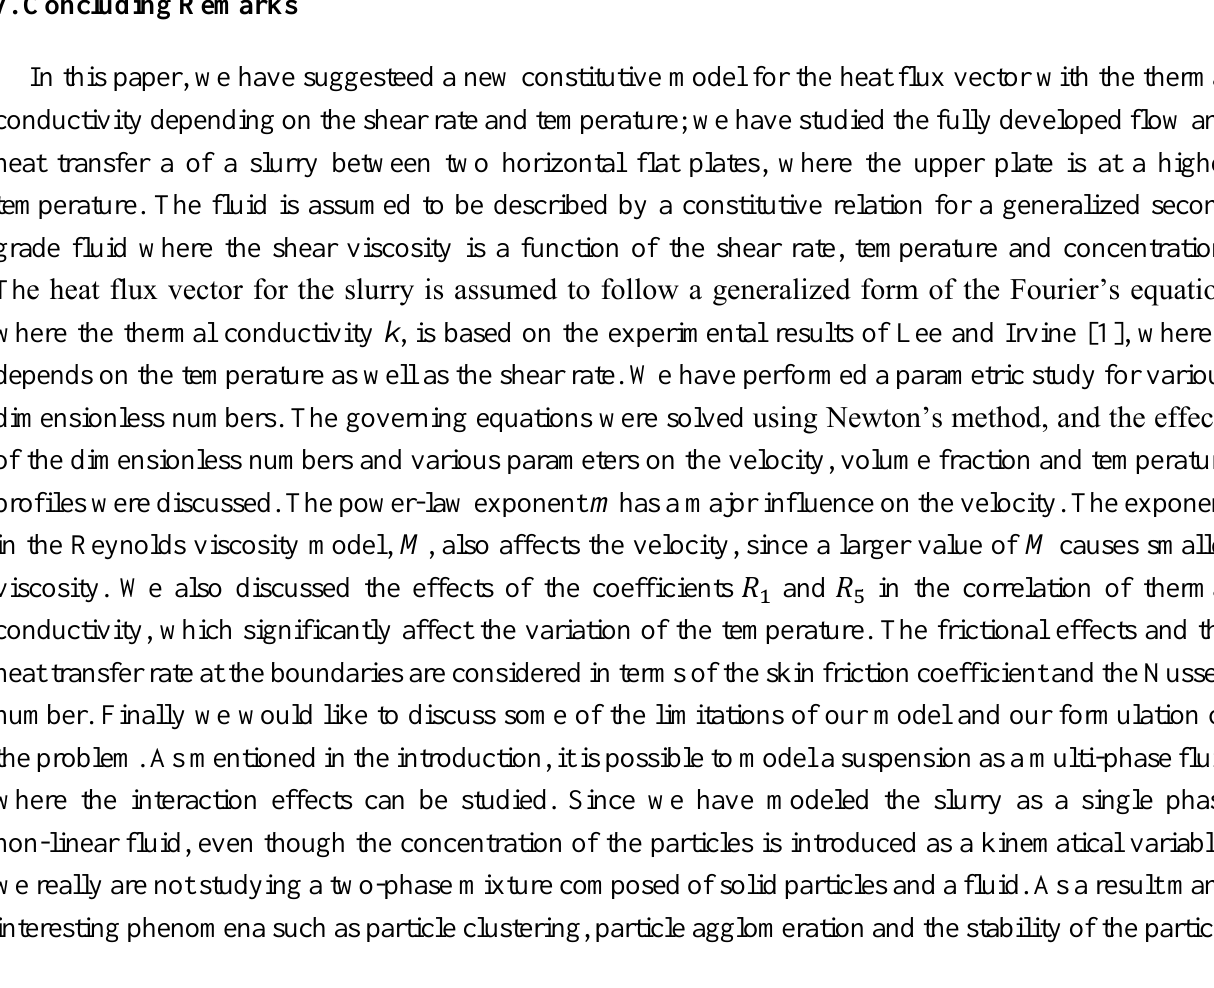
Table 5. 𝑚 = −0.3, 𝑀 = 1, 𝐵